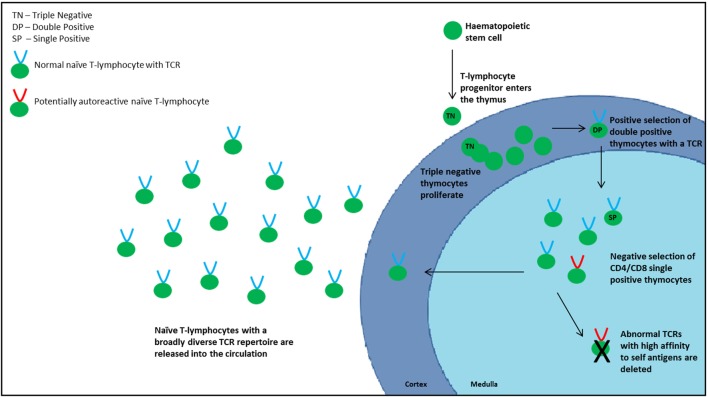
Normal thymopoiesis.